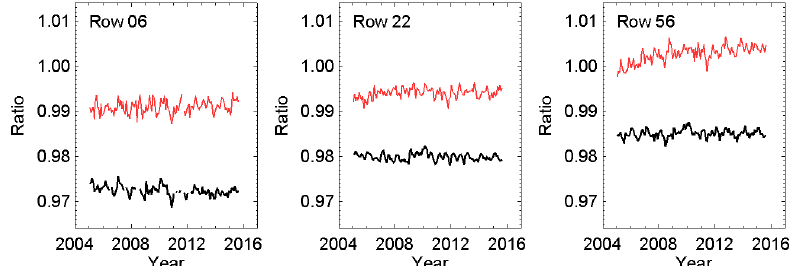
Figure 32. Trends in monthly mean ratios of OMI radiances measured at 340 and 354nm on the UV-2 detector (black) and 354 and 380nm on the VIS detector (red) for three detector rows. The observed trend in these Earth-view measurement ratios is <0.5% per decade in both channels. Detector rows 6, 22, and 56 shown here are among those which are unaffected by the row anomaly. The data shown here were selected to minimize geophysical effects of wavelength dependence and measurement geometry on the radiance ratios. Conditions are limited to high reflectance (ρ > 0 . 9 ) , low solar zenith angle (θ 0 < 50 ◦ ) over the tropical Pacific (20 ◦ N–S, 130–170 ◦ W), where radiation is scattered primarily by high altitude, and deep convective clouds and the observed atmosphere is generally free of aerosol. The more noticeable trend in row 56 is not understood. Despite specifically selecting data to minimize wavelength dependent effects, some residual geophysical variation remains in the ratios. These are most likely due to cloud scattering phase function variation with cloud water phase and from residual multiple scattering effects varying seasonally over the SZA range of the